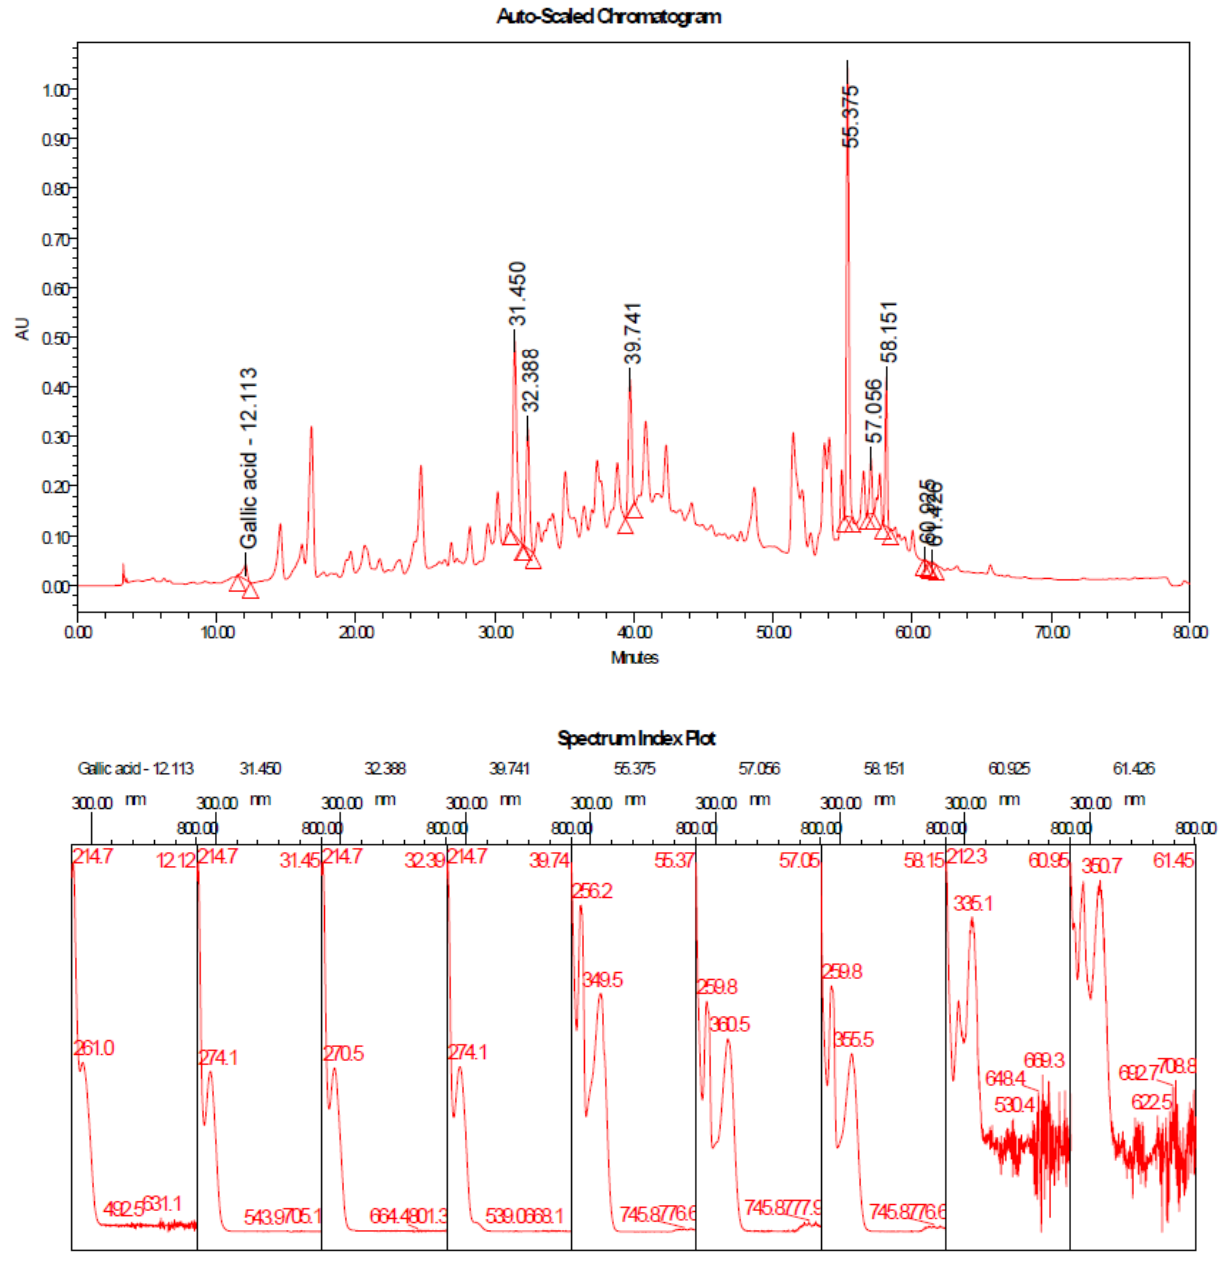
Figure 3. HPLC analysis and spectrum index plot of Taif Rose ( R. damascena) methanolic extract at 280 nm.